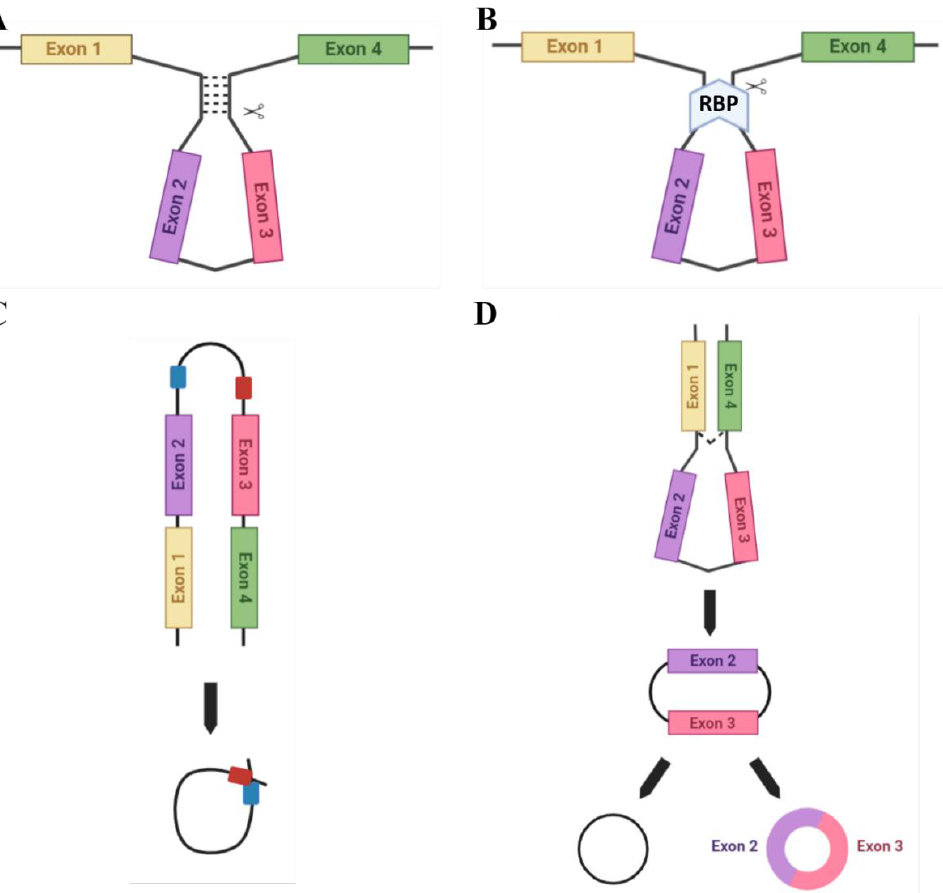
Figure 2. Methods of circRNA biogenesis. A number of different methods facilitate the circularisation of circRNAs: ( A ) Complementary base-pairing (e.g., via Alu repeats) promotes backsplicing due to spatial reduction in the splice sites. ( B ) RBP-driven circularisation occurs when RBPs bind flanking introns and bridge them together for splicing. ( C ) ciRNA formation: ciRNAs are formed from lariat introns that escape debranching. C-rich (red) and GU-rich (blue) sequence binding is sufficient for the intron to avoid debranching and generate a ciRNA. ( D ) The lariat-driven model of circularisation. Exon-skipping occurs to bring splice sites into close proximity.